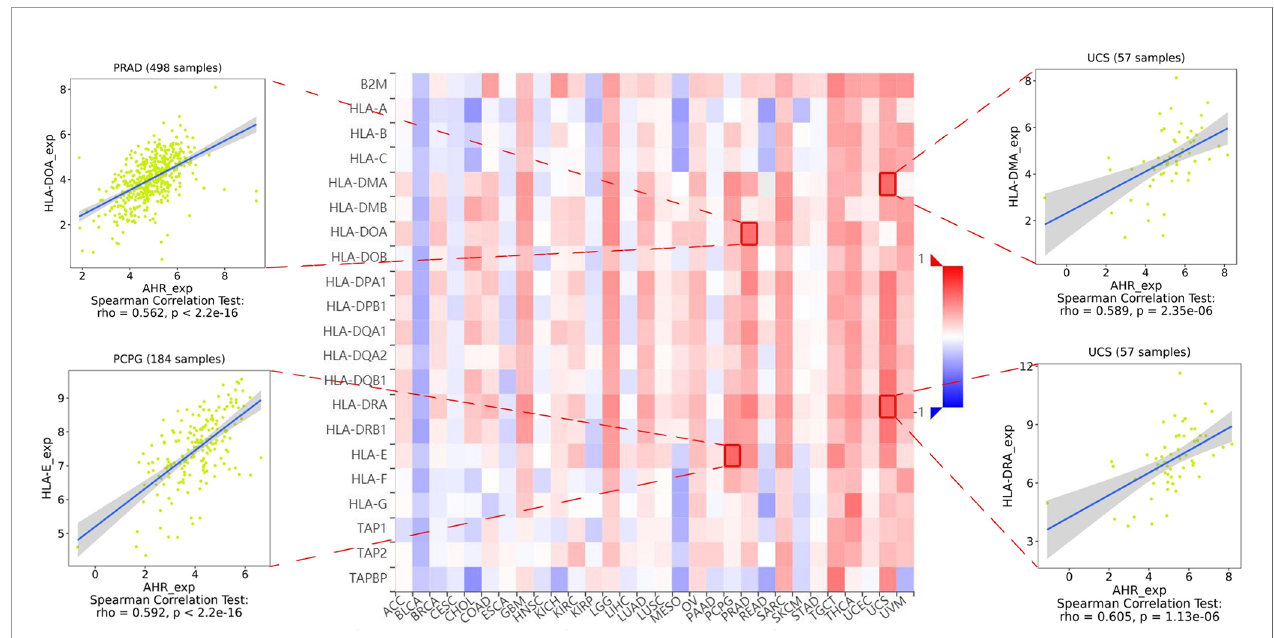
FIGURE 8 | The expression correlation between AhR and MHC molecules. Red indicates positive correlation whereas blue indicates negative correlation. The top 4 strongest associations were displayed via